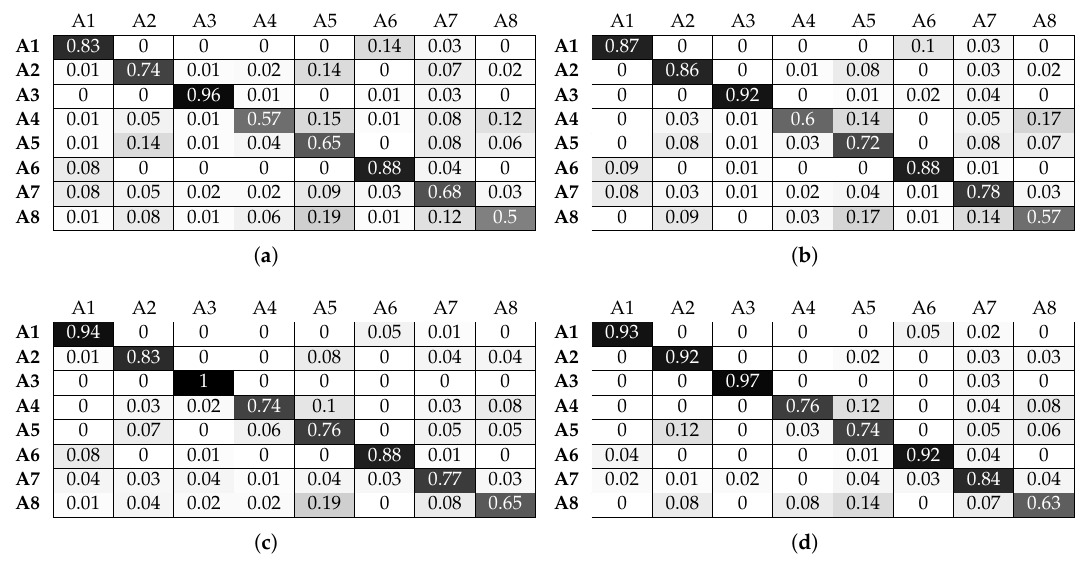
Figure 15. Normalised confusion matrices for random forest, with Wearable Feature Type 2, with beacon data. ( a ) n = 48, w = 1 s; ( b ) n = 46, w = 2 s ; ( c ) n = 42, w = 3 s; ( d ) n = 41, w = 4 s.